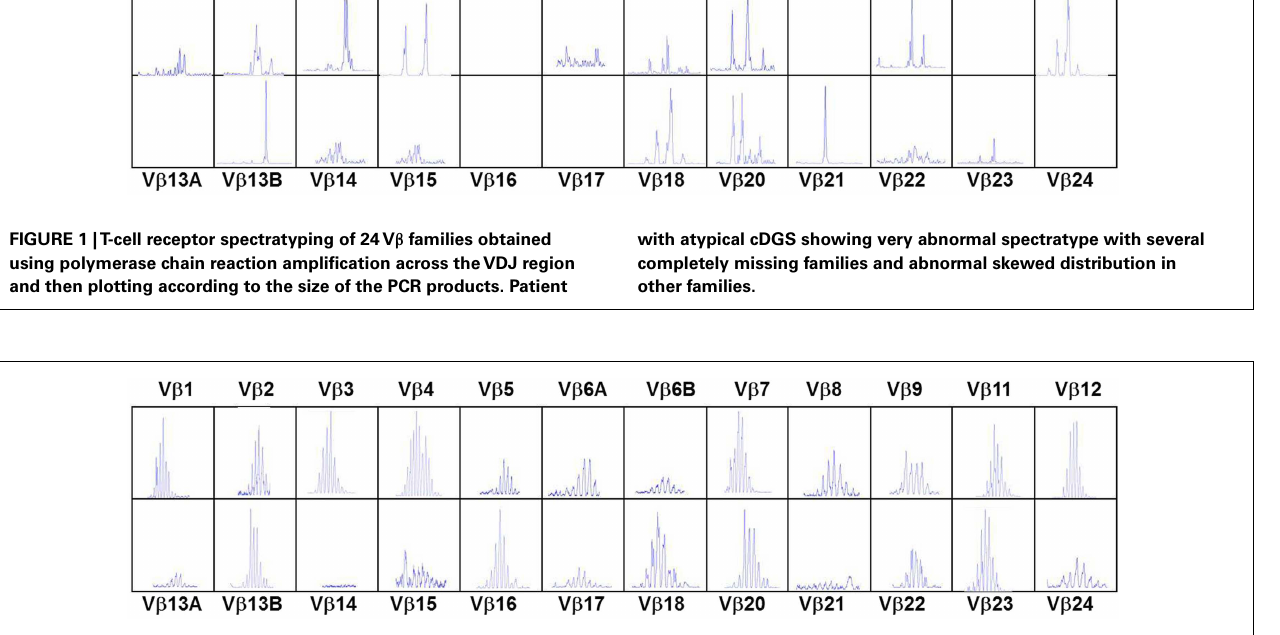
Frontiers in Immunology |T Cell